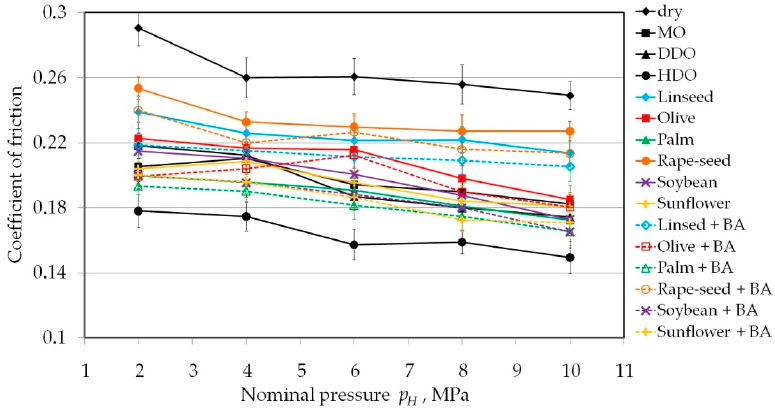
Figure 3. The effect of nominal pressure in the range between 2 and 10 MPa on the value of COF.